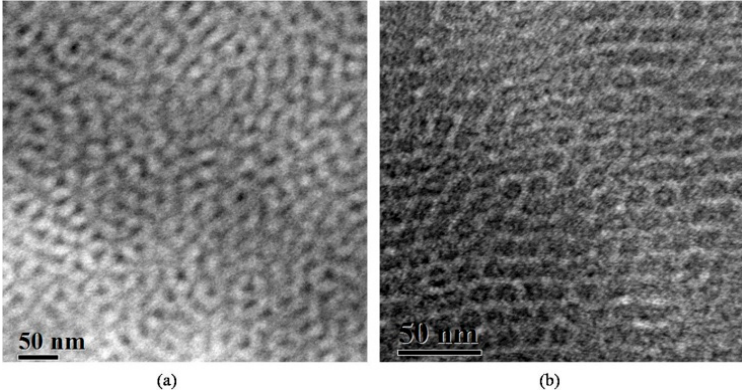
Figure 2. TEM images of the PS- b -PB 1,4 - b -PDMS terpolymer (sample 2). ( a ) Unstained sections where a 2-phase morphology consistent with the DG structure is evident. Dark areas correspond to PDMS segments and gray to the PS / PB 1,4 mixed blocks. The existence of high symmetry projections (three-fold and four-fold) justifies the cubic morphology. ( b ) Sections stained for 60 min with vapors of OsO 4 , leading to a very distinct three-phase cubic microdomain structure consistent with the core–shell gyroid morphology. Black corresponds to PB segments, white to PS and gray to PDMS domains.